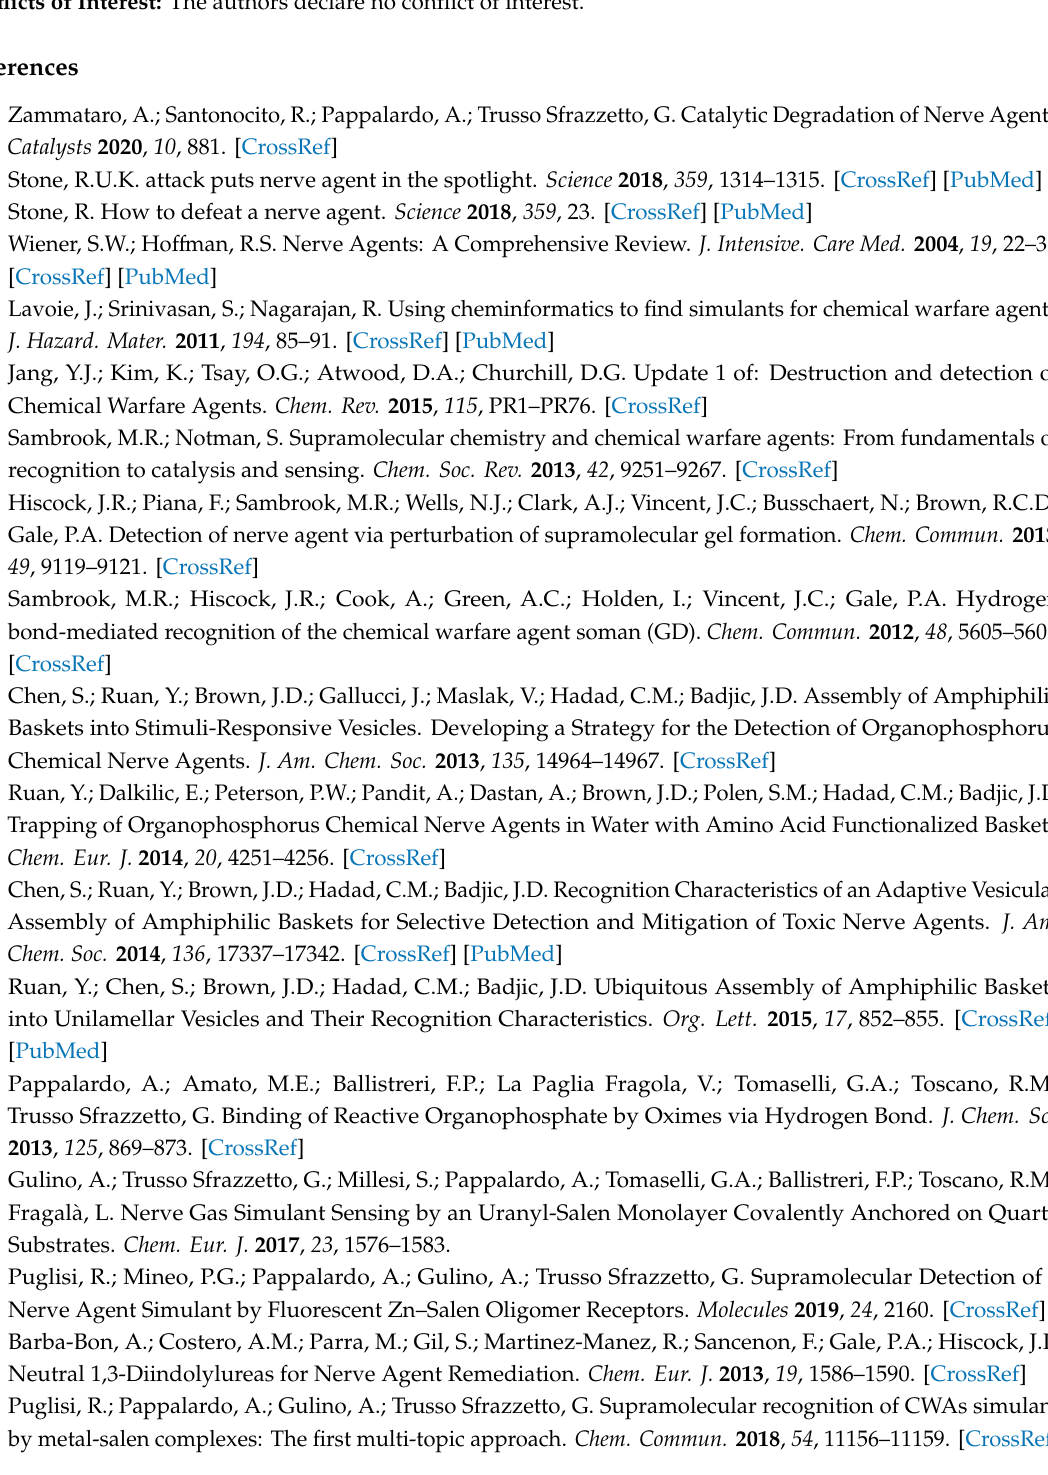
Supplementary Materials: The following are available online. Figure S1: 1H-NMR spectrum of CNPs-Naphthyl- Di-AE in DMSO- d 6 ; Figure S2: UV-Vis titration between CNPs-Naphthyl-Di-AE and